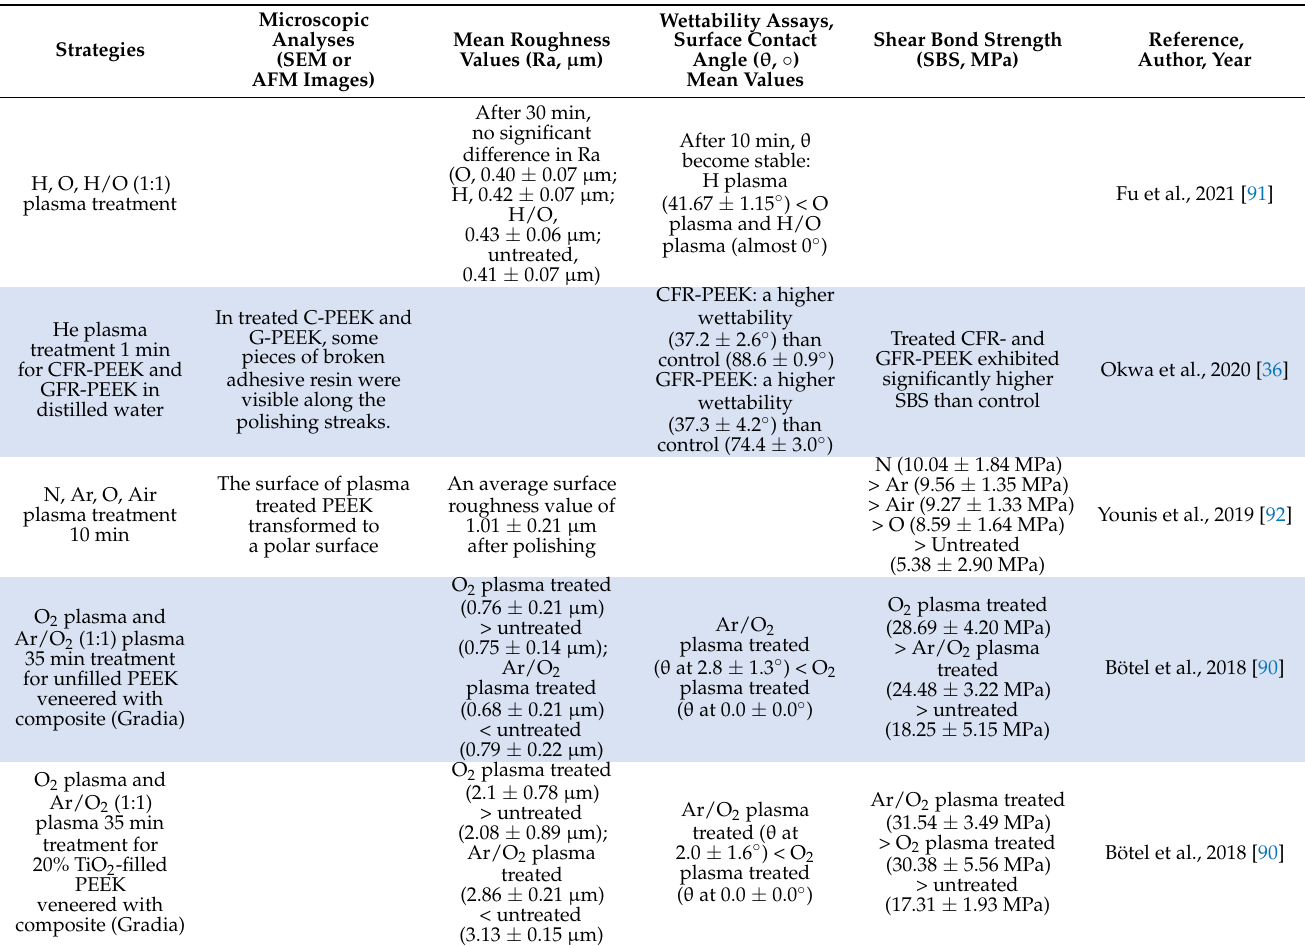
Table 3. The application of plasma treatment for the improvement of PEEK adhesion